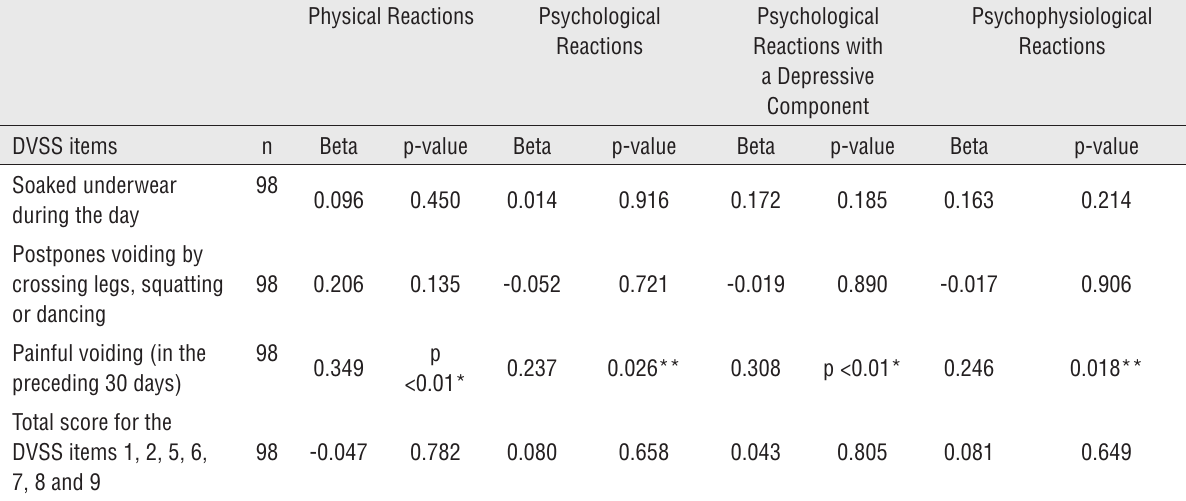
Table 4 - Linear regression analysis between the items evaluated in the Dysfunctional Voiding Scoring System (DVSS) and the domains of the Child Stress